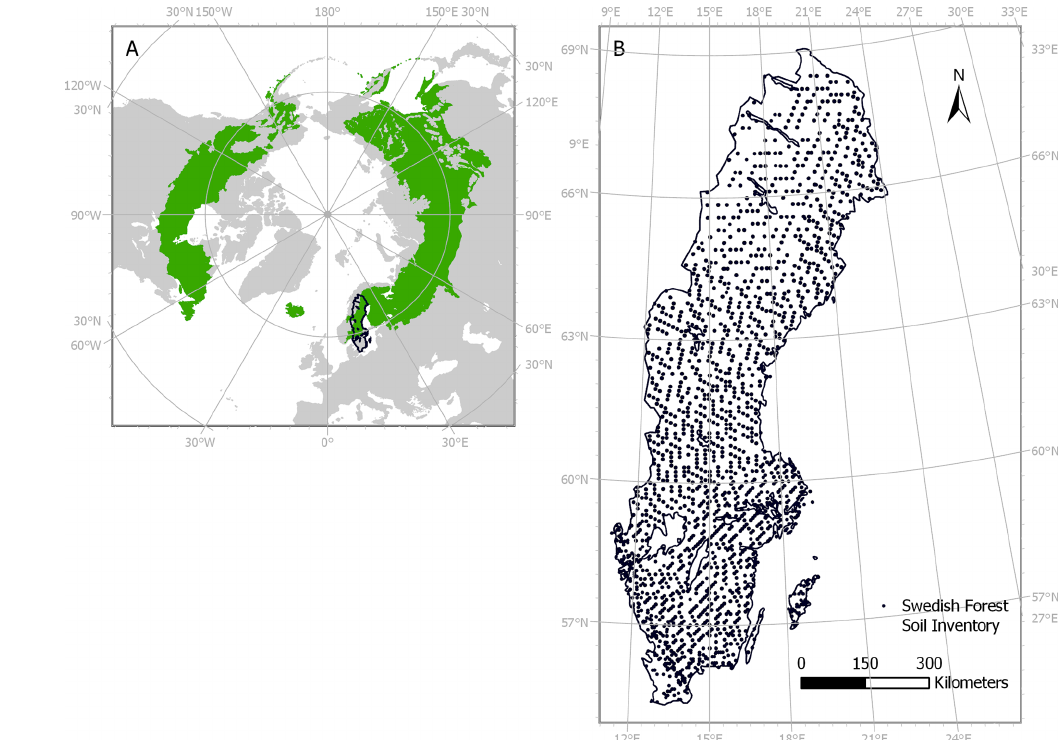
Figure 1. (a) Sweden’s position in the northern boreal zone/taiga; map data from Dinerstein et al. (2017). (b) Black dots indicate the sites for the Swedish Forest Soil Inventory (Olsson, 1999; Stendahl et al., 2017) where the thickness of the organic layer has been measured ( n = 5479).